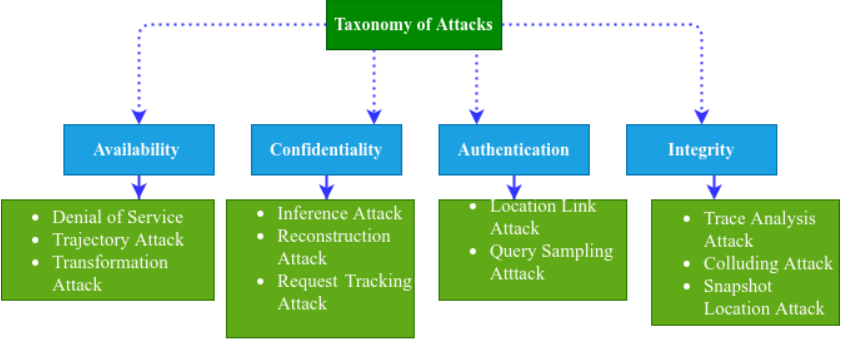
Figure 3. Classification of